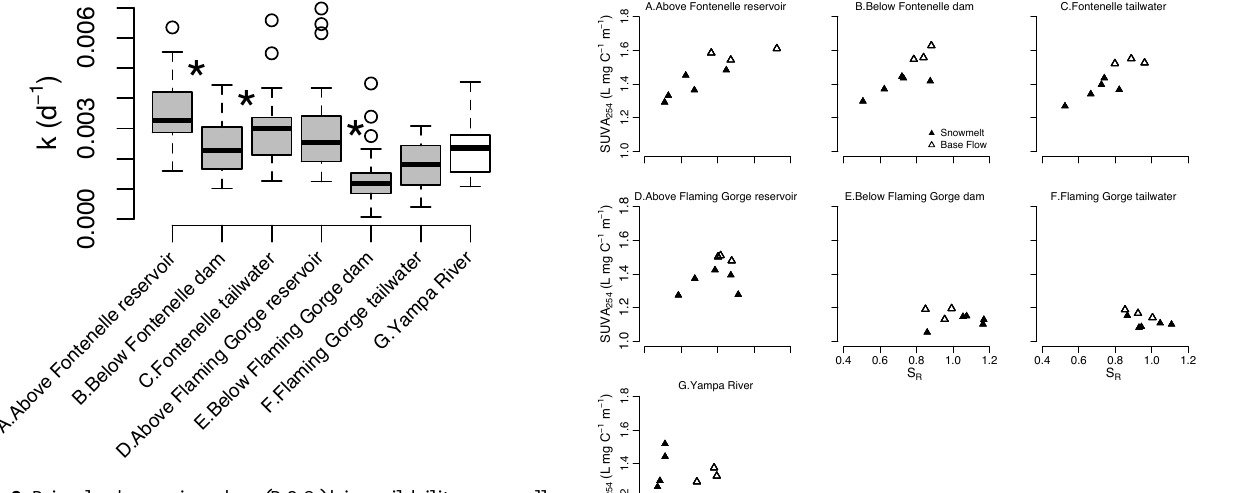
Figure 3. Dissolved organic carbon (DOC) bioavailability across all sampling sites as measured by the DOC decay rate per day ( k , d − 1 ) . The black line represents the median value of k (d − 1 ) , the boxes are the upper and lower 25th and 75th percentile, the tails represent the smallest or largest values within 1.5 times the size of the box, and the open circles are considered outliers as they exceed 1.5 times from the 25th or 75th percentile. The asterisk ( ∗ ) indicates signifi- cant differences (paired t test, p <0.05) in bioavailability between sites. Letters A–G preceding the site names correspond to sites A–G in Fig. 1.